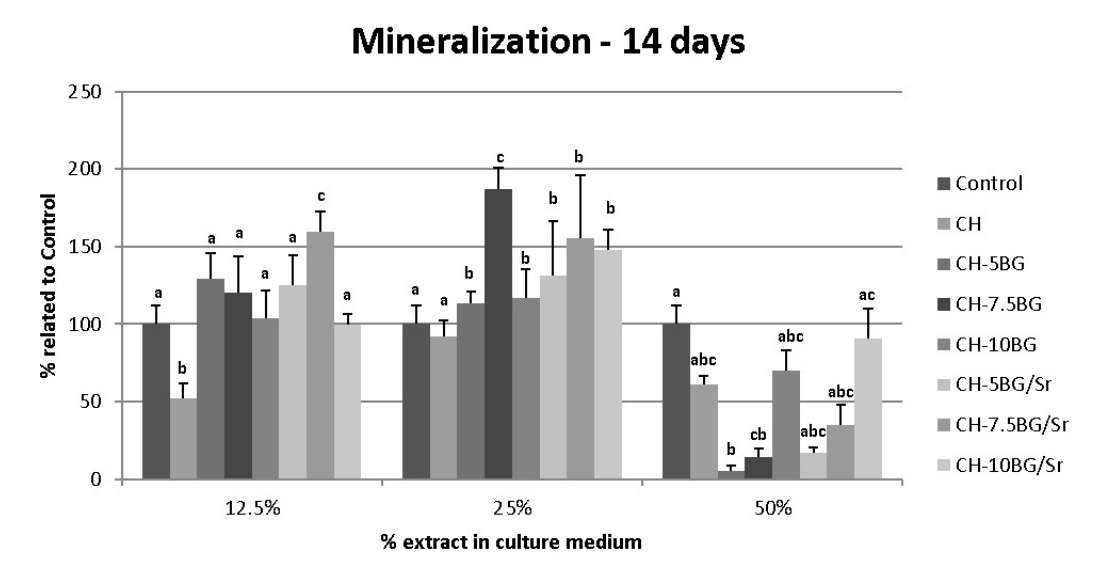
Figure 11. Biochemical quantification of mineralization in osteoblastic cultures of the MC3T3-E1 strain exposed to extracts of compositions based on calcium aluminate cement (CH) containing different contents of bioactive glass (BG) and strontium (Sr) in concentrations of 12.5%, 25% and 50% for 14 days. Different letters between the samples indicate a significant difference between groups at the same concentration (Kruskal Wallis / SNK, p